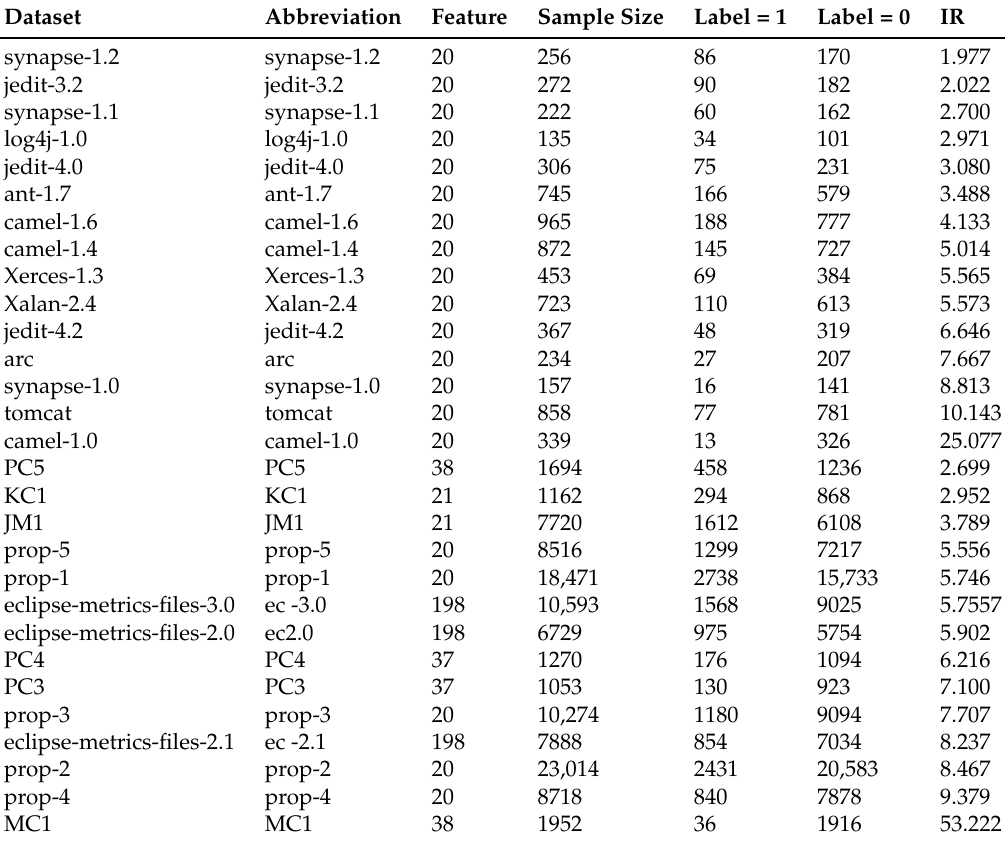
Table 1. Description of software defect